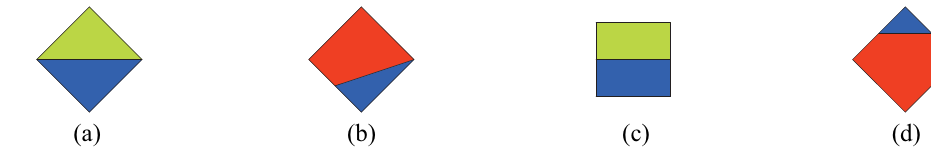
Figure 9. Ways of cutting of a square, left to right: (a) VV 1,3,C (b) VS 1,2 (c) SS 1,3,C (d) SS 1,2